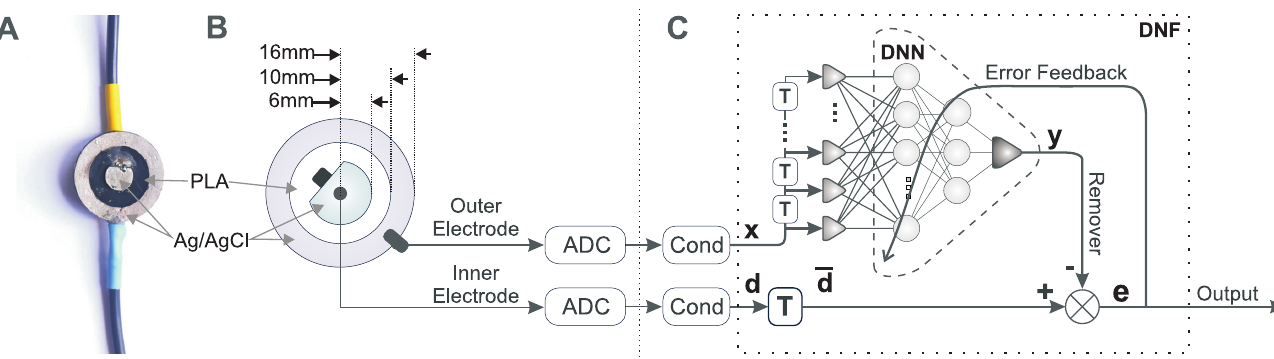
Fig 1. Electrode and deep neural filter. A: Photo of the manufactured compound electrode. The top wire (yellow) connects to the inner electrode and the bottom wire (blue) to the outer ring electrode. B: Top schematic view of the new compound electrode showing the inner electrode and the outer ring electrode. C: Signal processing of the two signals originating from the inner and outer ring electrodes: ADC = Analogue Digital Converter, Cond = standard signal conditioning such as high-pass filtering and 50 Hz removal. T = time delay.